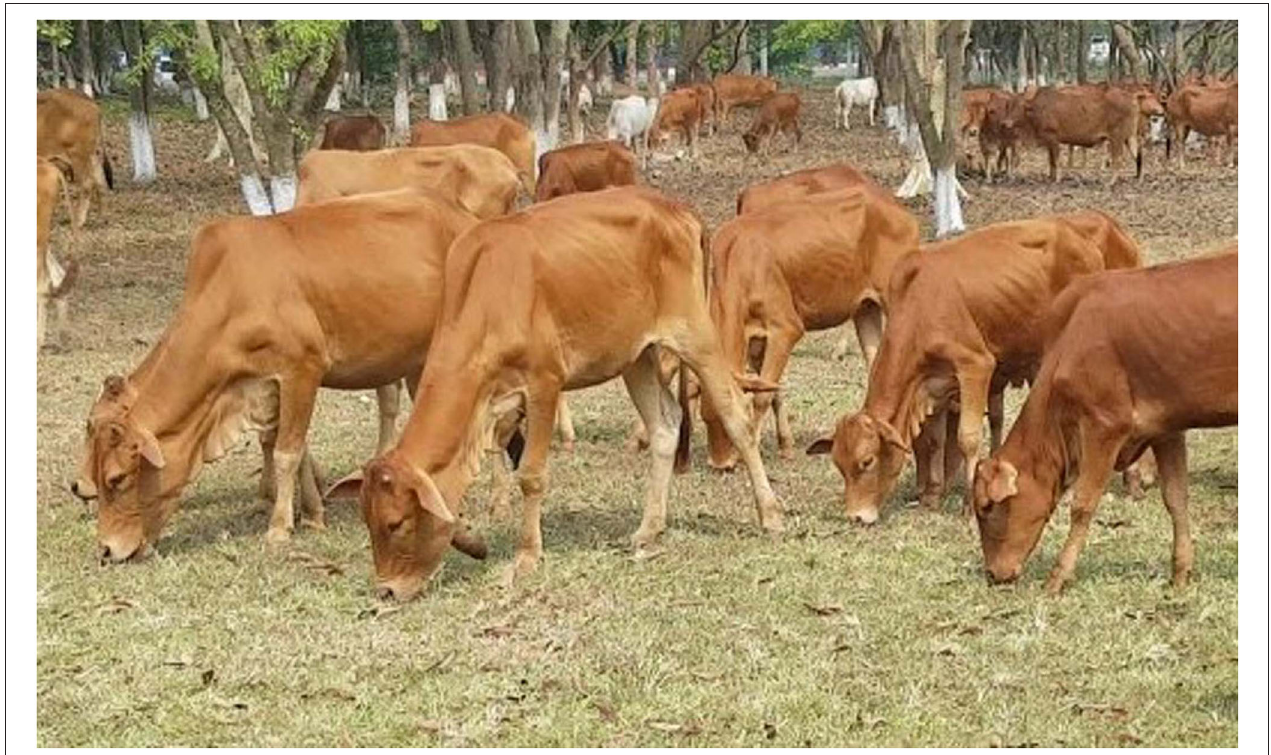
FIGURE 2 | Red Chittagong cattle of